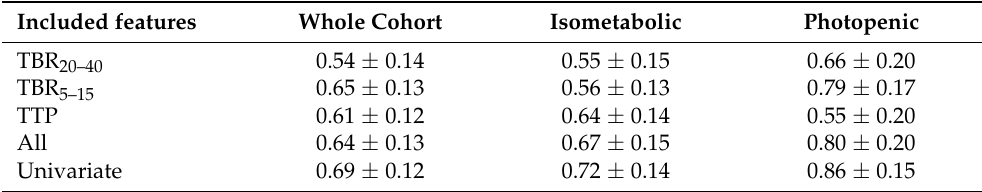
Table 2. Mean and standard deviation of AUC values obtained using logistic regression classification with 50-repeated 5-fold